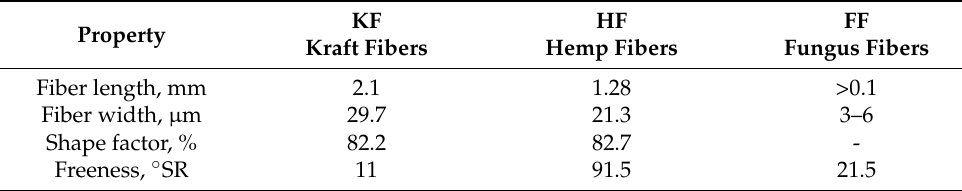
Table 1. Properties of cellulose and fungal fibers used for composite materials. KF Property Kraft Fibers